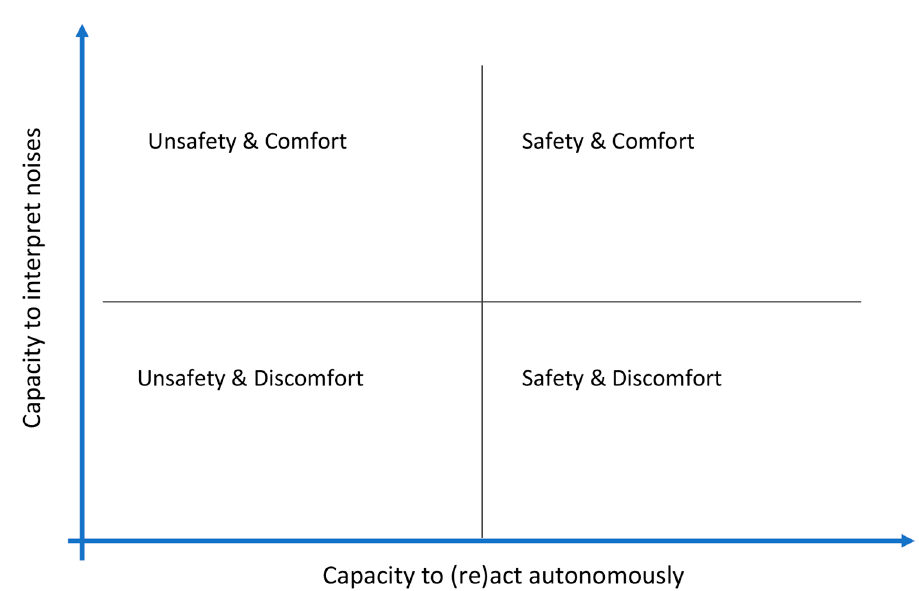
Figure 1. The four personae derived from the data show the interaction between the person’s capacity to interpret sounds and their capacity to react to them.